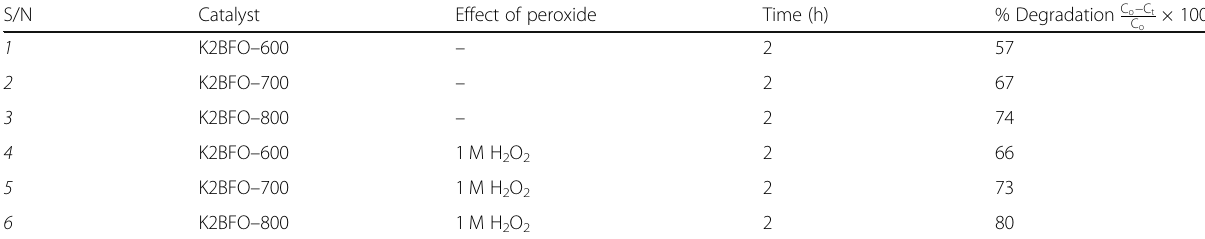
Table 2 Degradation efficiency (%) of K2BFO on MB in the presence and absence of peroxide S/N